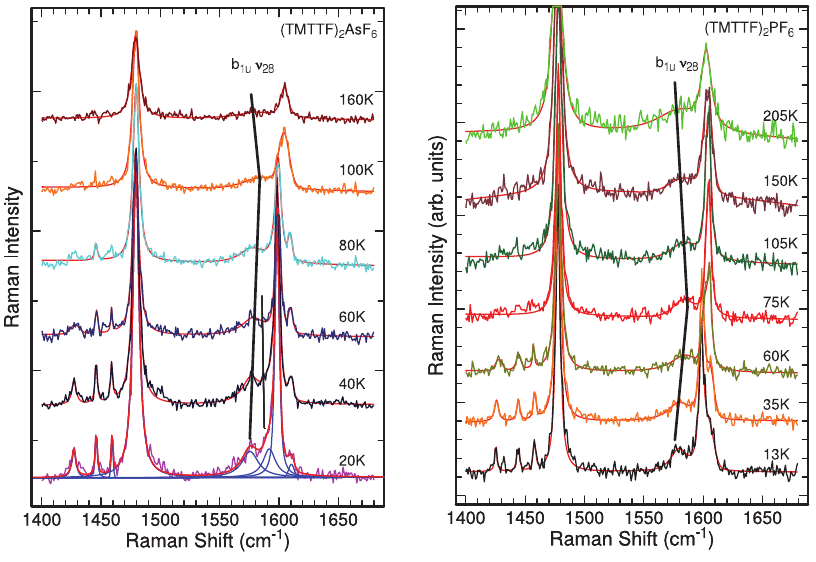
AsF and (TMTTF) 2 6